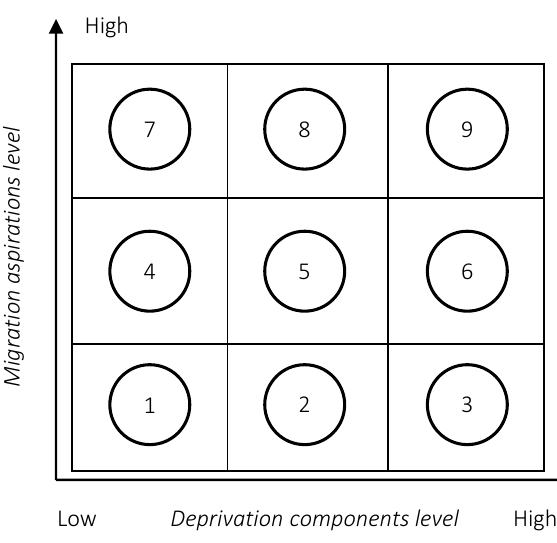
Figure 6. Matrix of migration capacity: weighing migration aspirations and socio-economic